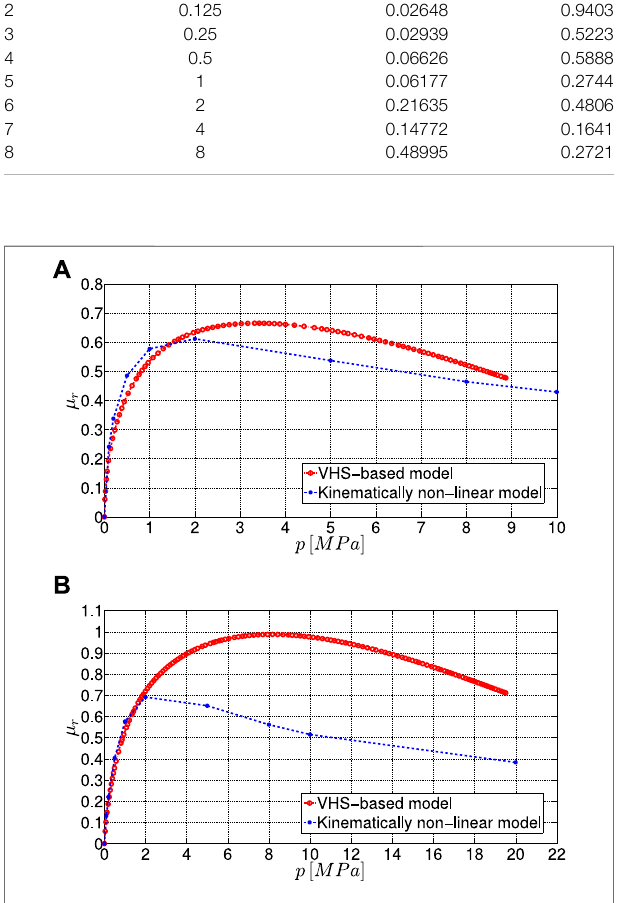
FIGURE 7 | Friction coef fi cient as a function of the applied pressure for the high-slope wavelength, at a velocity of (A) 10 [mm/s], (B) 50 [mm/s].